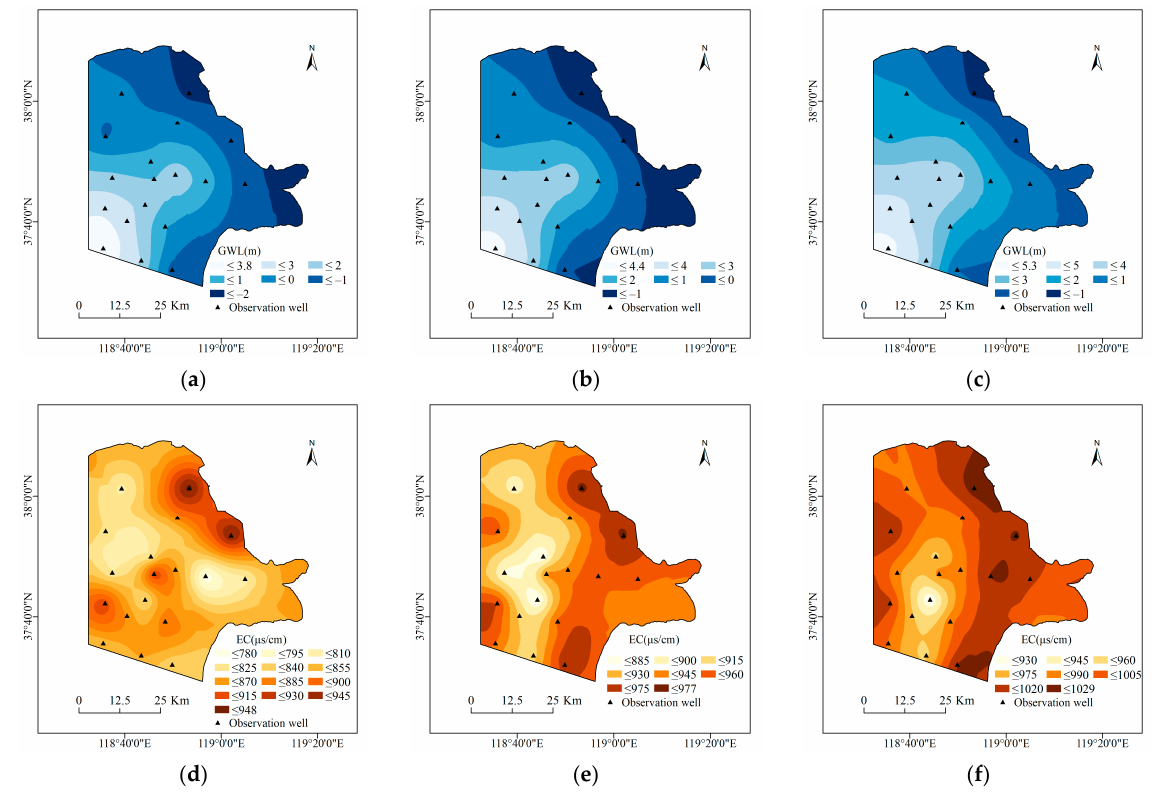
Figure 2. The distributional maps of groundwater level (GWL) and electrical conductivity (EC) in three scenarios: ( a ) 5% percentiles groundwater levels; ( b ) mean groundwater levels; ( c ) 95% percentiles groundwater levels; ( d ) 5% percentiles groundwater ECs; ( e ) mean groundwater ECs; ( f ) 95% percentiles groundwater ECs. Table 1. The area with different severities of seawater intrusion according to groundwater